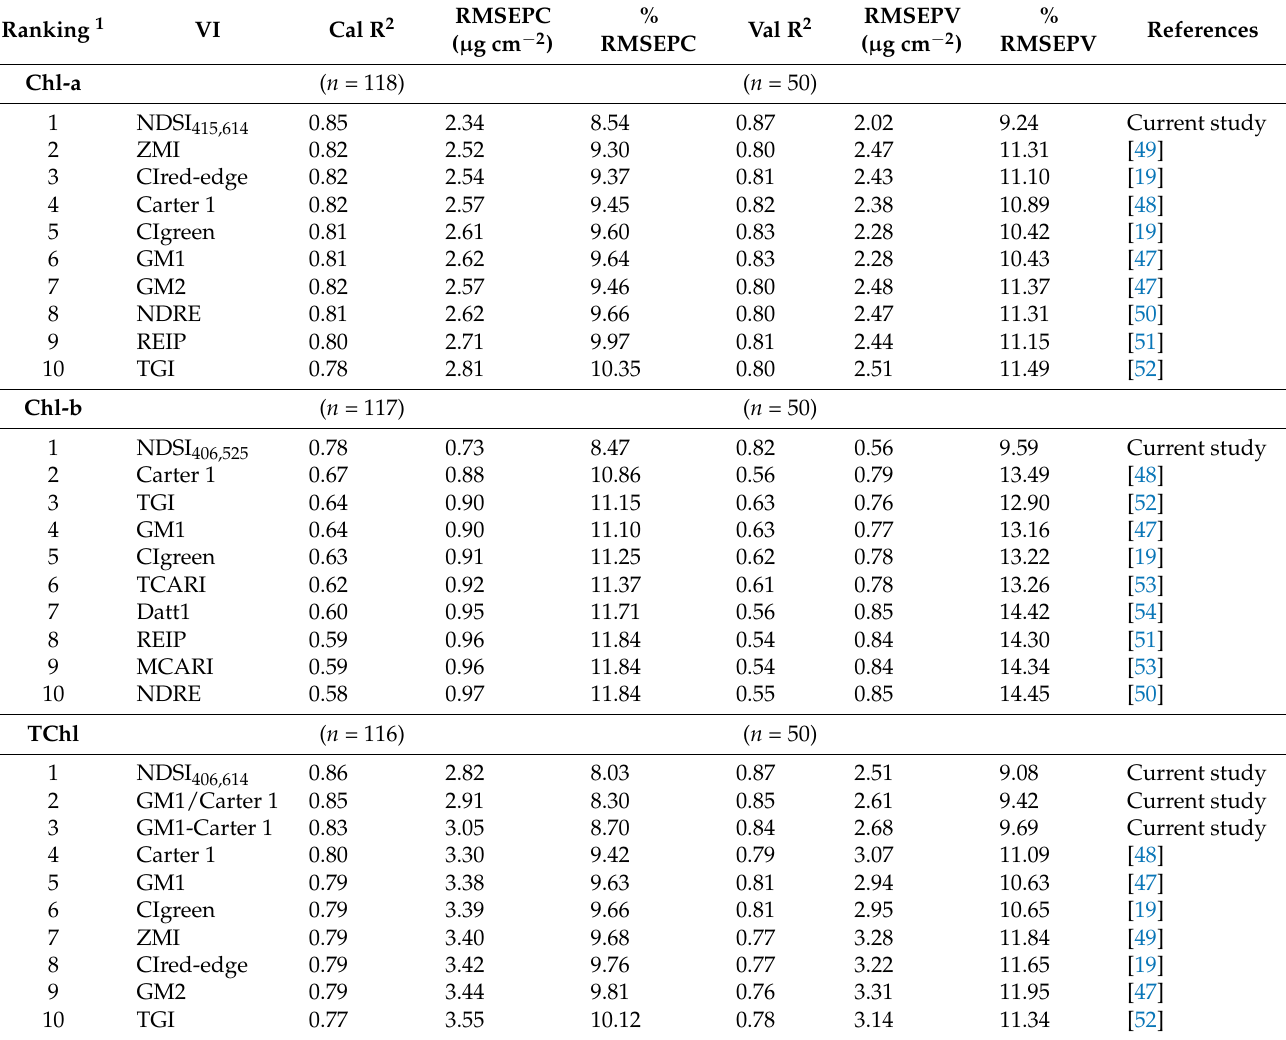
Table 1. The top ten predictions for Chl-a, Chl-b, and TChl are presented based on all 33 VIs, NDSI-generated VIs from the leaf reflectance spectra by the PolyPen